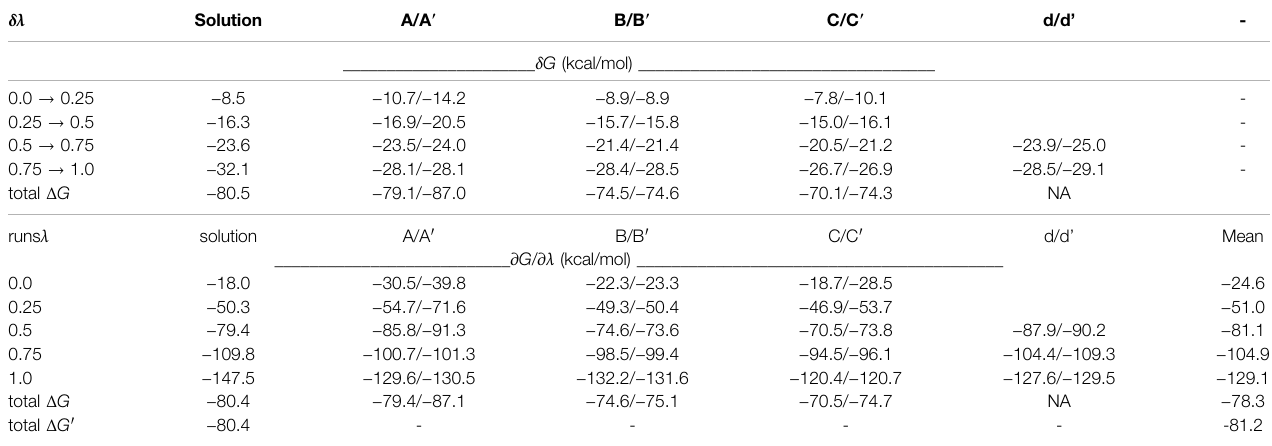
TABLE 1 | FEP results for PLP phospate